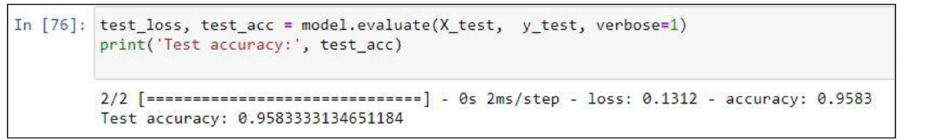
Figure 4. Model Evaluation. The figure visualizes the evaluation results for the model when classifying the testing set where an accuracy of 95.83% was